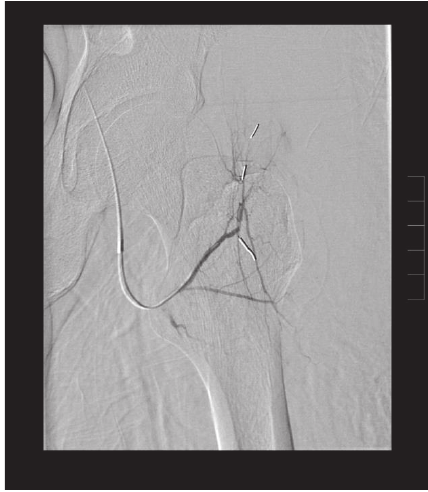
Figure 5: Postembolization angiogram confirms that hemostasis has been achieved.